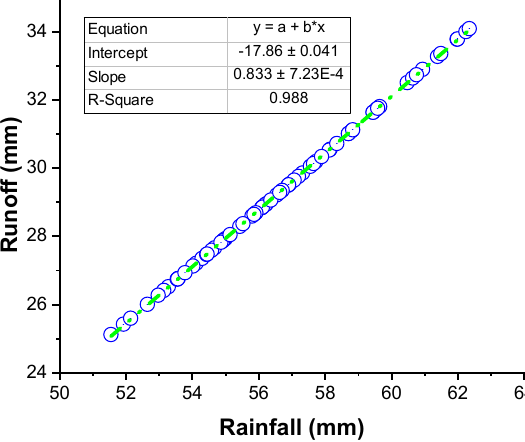
Figure 15. The rainfall and SCS-CN runoff relationship for the study area.